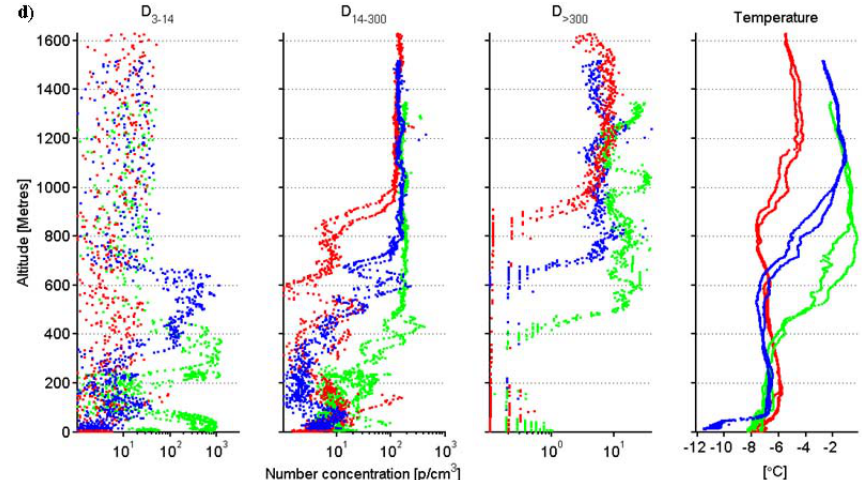
Fig. 9d. Vertical profiles of aerosol particle number concentration and temperature during ASCOS 2008 expedition helicopter flights, Pe- riod 4: 19:53–20:13UTC, 31 August (DoY 244) 2008 (red); 07:32–07:55UTC, 1 September (DoY 245) 2008 (blue); 17:19–17:40UTC, 1 September (DoY 245) 2008